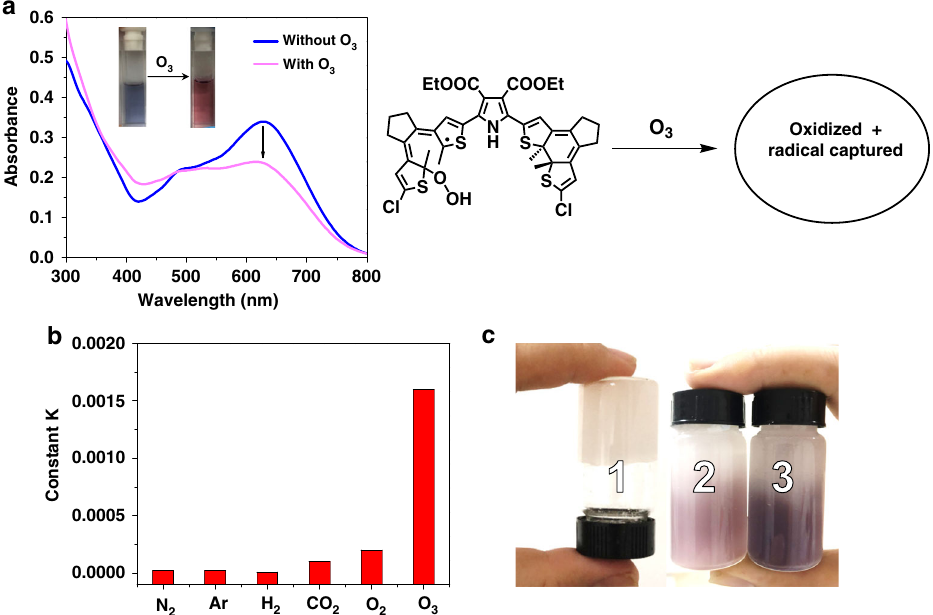
Fig. 5 Application for visualizing ozone detection. a UV – vis absorption spectral changes of compound 1 (1.0 × 10 − 5 M) in CHCl 3 solution at the photostationary state in the presence of O 3 at 25 °C. Inset: the corresponding solution color change. b The rate of absorbance changes at 630 nm of photo- irradiated compound 1 in CHCl 3 solution after bubbling with various types of gas. c A gel of compound 1 containing chloroform: 1. the original state; 2. O 3 bubbled photostationary state; 3. the photostationary